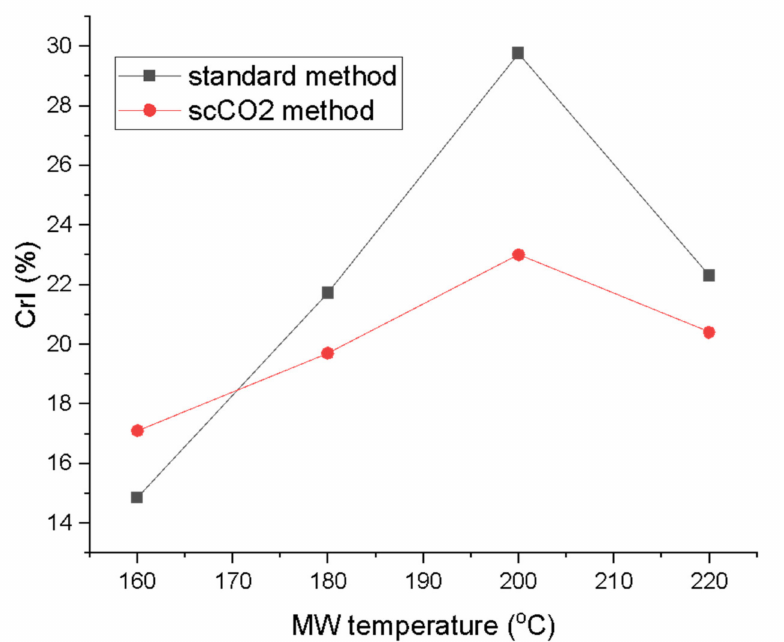
Figure 7. Crystallinity index (CrI) of MFC from standard and scCO 2 methods at different MW temperatures calculated from XRD traces in Figure 6 via Segal’s method. NB. ‘Standard’ refers to without any scCO 2